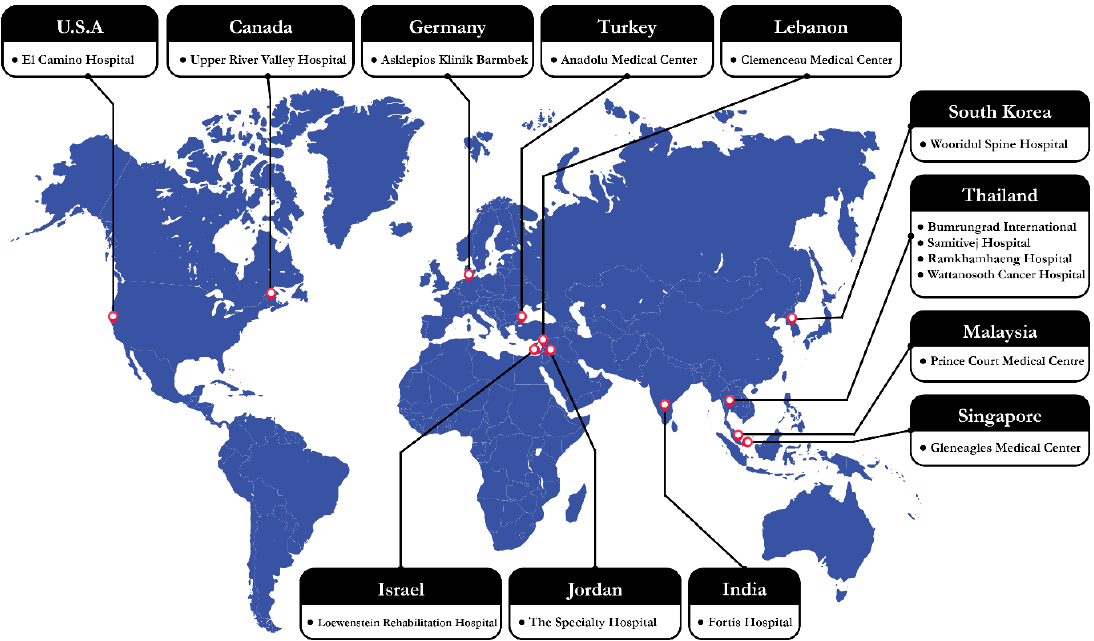
Fig. 1. Some of the famous hospitals and medical centers in terms of attracting medical